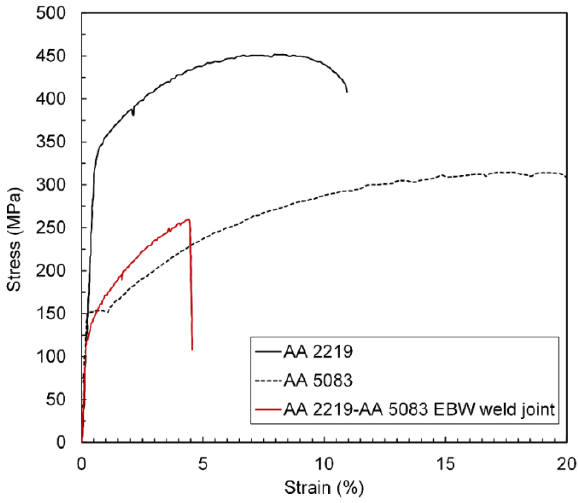
Figure 15. Stress-strain plots of AA 2219-T6 base material, AA 5083-H116 base material, and dissimilar AA 2219-AA 5083 EB weld.